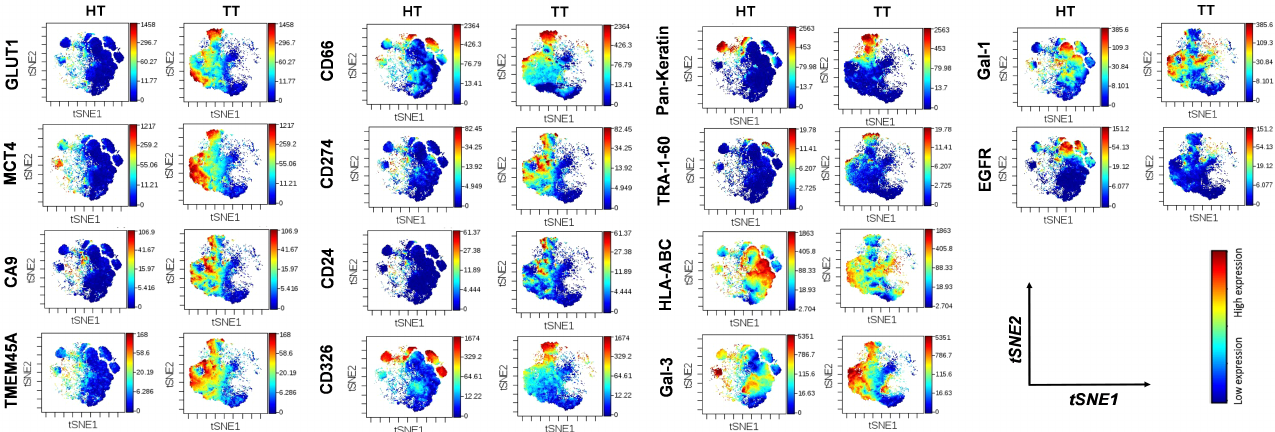
Figure 7. Single-cell intratumor heterogeneity of human primary lung adenocarcinoma. The viSNE analysis of single cells shows differential expression of GLUT1, MCT4, CA9, TMEM45A, CD66, CD274, CD24, CD326, pan-keratin, TRA-1-60, HLA-ABC, Gal-3, Gal-1, and EGFR in human primary lung adenocarcinoma. Mass cytometry revealed intratumor heterogeneity of human primary adenocarcinoma at protein level with single-cell resolution. The viSNE analysis displays the cell-surface-expression pattern of markers of single cells isolated from TT versus cells from HT of the same patient.